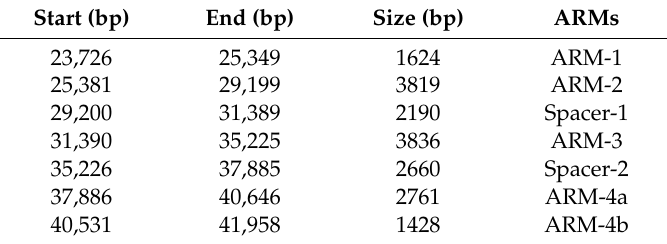
Figure 5. Dotplots of the male-specific inverted repeats in the SDR on the Y chromosome and comparison to the closest paralogous gene Po14v11g057342m. ( a ) A dotplot of the alignment between male-specific inverted repeats in the SDR in P. trichocarpa Stettler-14 to the region of PtRR9 Po14v11g057342m on chromosome 19. ( b ) A dotplot of the self-alignment from the genomic sequence from 15,907,432 to 15,910,397 on chromosome 19 where PtRR9 is located. ( c ) A dotplot of the self-alignment between the genomic sequence from 20 kb to 45 kb on chromosome 19 where male-specific inverted repeats are located. ( d ) A mirror image of the dotplot of a. Light purple colored bands show positions of two spacers in the SDR, and the cyan colored one shows the position of PtRR9 . Schematics of the full-length PtRR9 gene and repeated fragments are shown at the bottom. The green box represents a fragment of the HEMA gene. Table 4. The physical positions of inverted repeats in Y-SDR